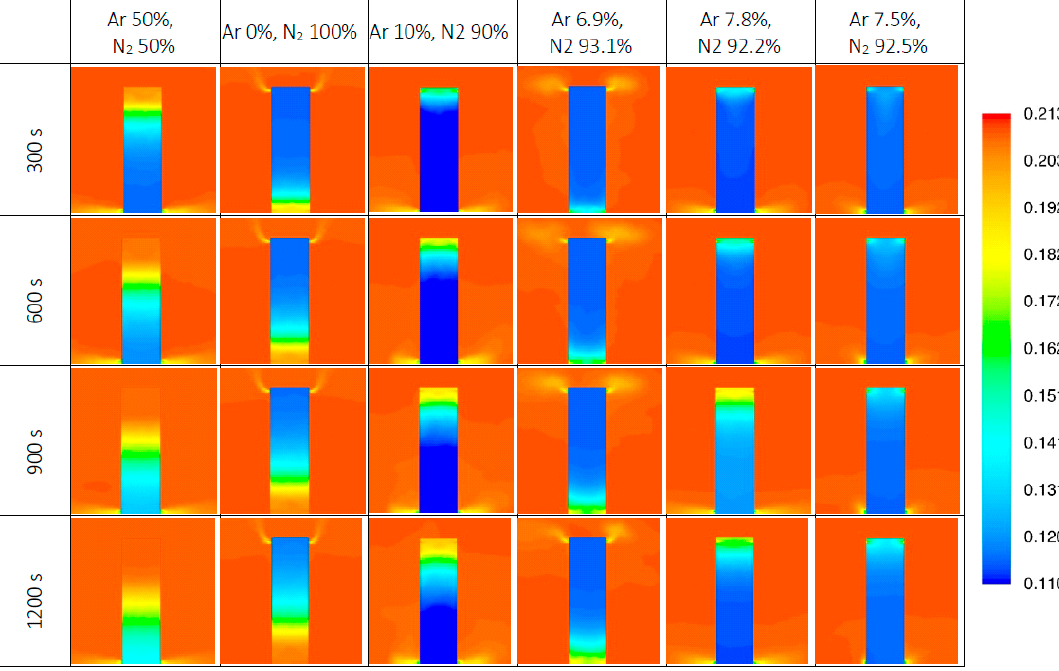
Figure 10. Oxygen concentration distribution in the test chamber in chosen time points for all evaluated scenarios (Table 1). In cases 2 and 4 the gas escapes the protected chamber through top leakage. Prolonged protective effect of gas mixtures 3–6 may be noted.